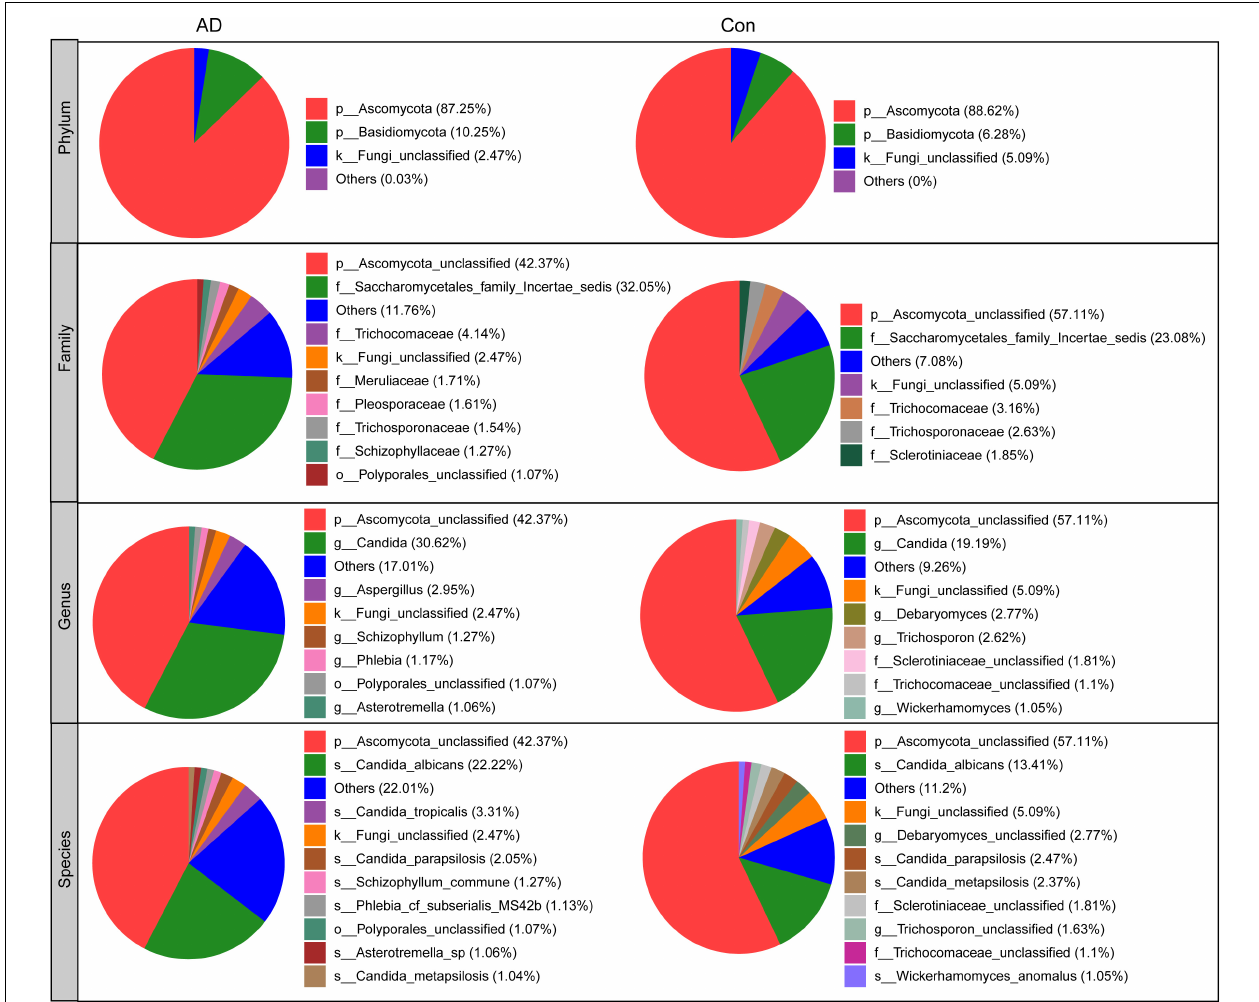
FIGURE 2 | Overall fungal microbiota composition in stable AD patients and healthy controls in phylum, family, genus, and species